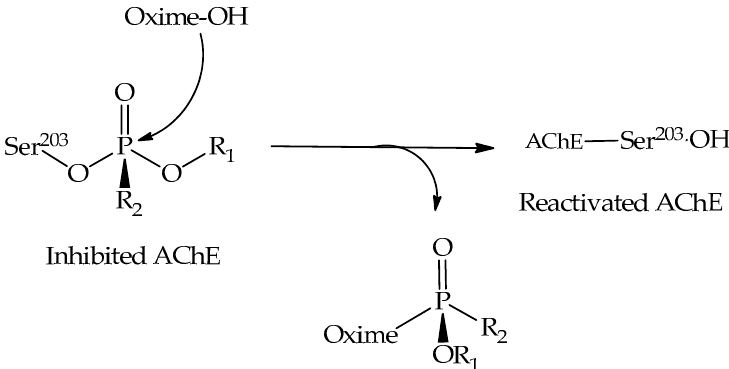
Figure 9. General representation of the reactivation process of the inhibited acetylcholinesterase (AChE).